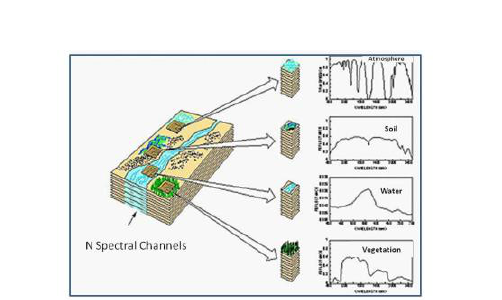
Figure 1. The IS concept: an IS image is composed of N spectral bands that generate a spectral cube. For each pixel, a spectrum can be extracted representing a spectral footprint of the object (taken from JPL: AVIRIS